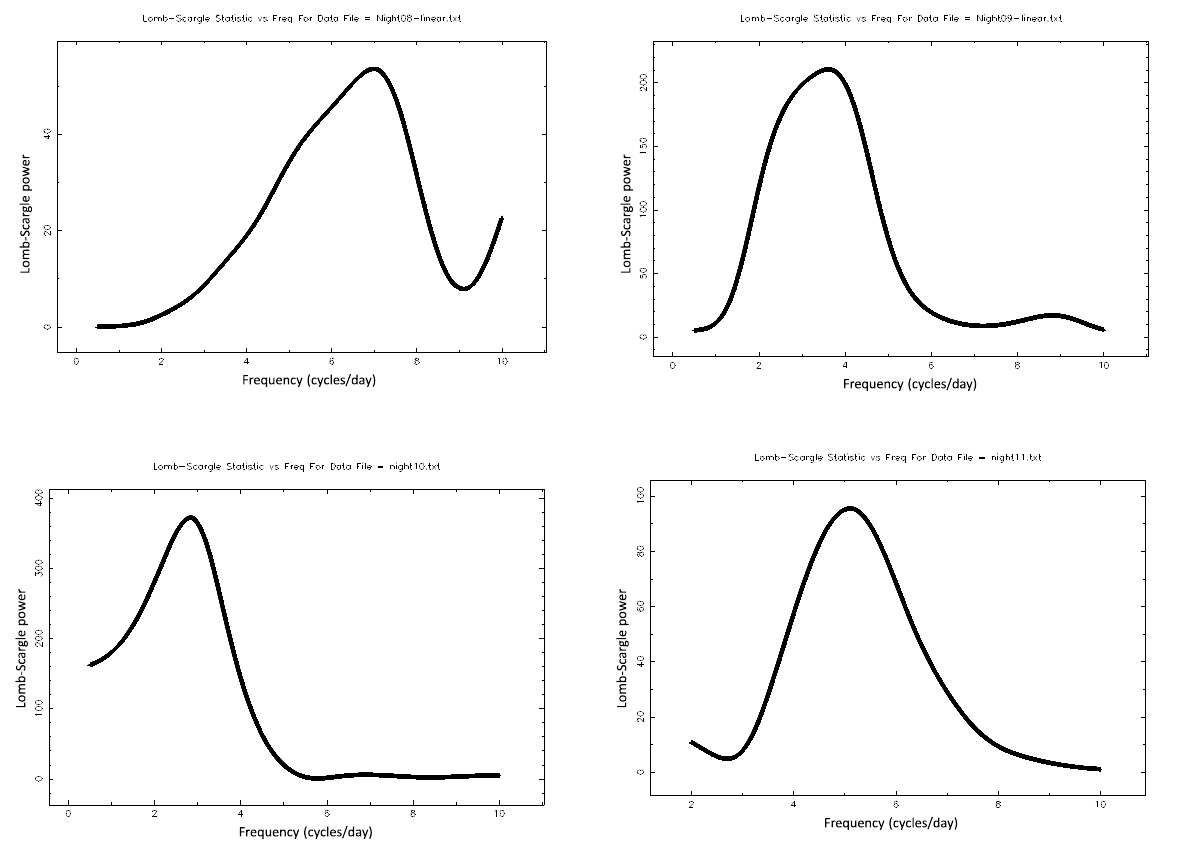
Figure 4: Lomb-Scargle power plots for the four outburst nights. By far the strongest signal is on night 3, with a maximum power of ∼ 350. The maximum power on the other nights are: ∼ 50 (night 1), ∼ 200 (night 2) and ∼ 100 (night 4). The dominant periods on nights 1 to 4 are 0.1433 d, 0.27-0.28 d, 0.35273 d and 0.1963 d respectively. The horizontal axis is frequency, in